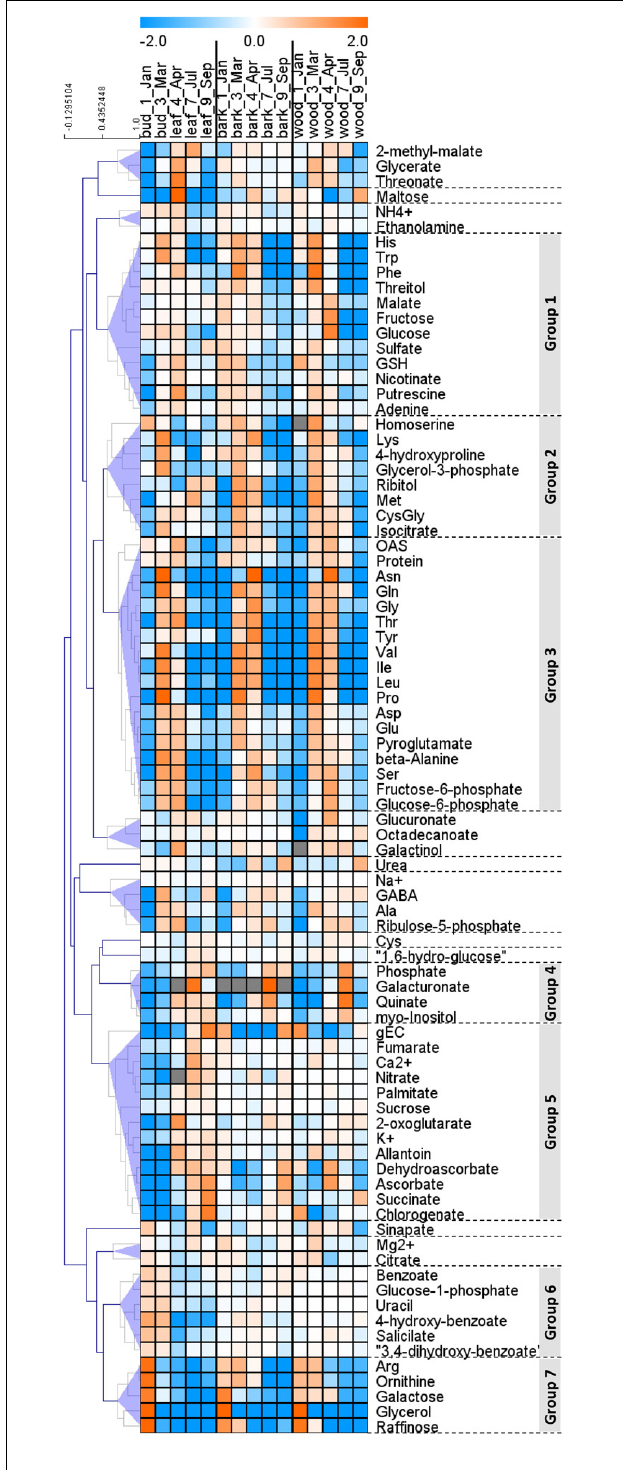
FIGURE 3 | Hierarchical clustering (HCA) of metabolite changes in buds/leaves, twig bark, and wood of poplar during annual growth. Hierarchical clustering of the changes of 85 annotated metabolites. The 85 outer nodes were reduced to 17 by imposing a distance threshold, 0.5 ( shaded blue ). The groups highlighted in gray are described further in Section